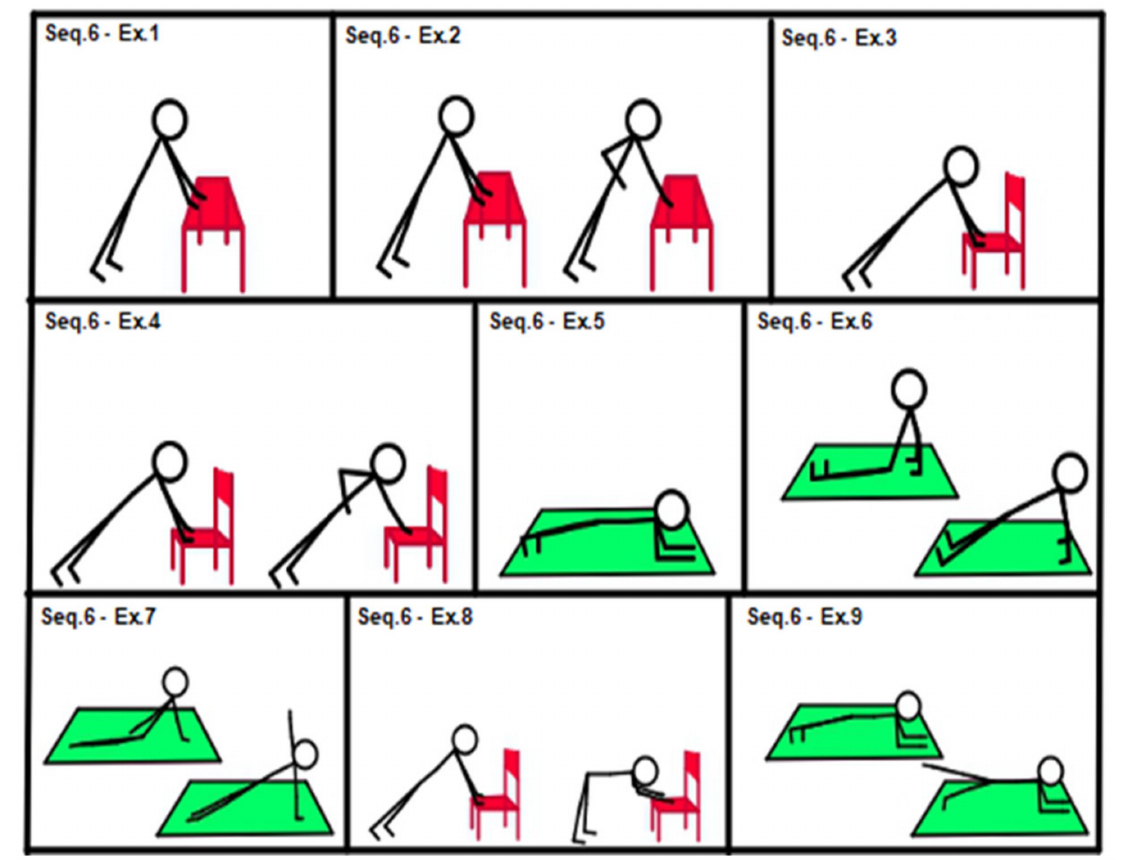
Figure 6. Sequence 6: core stability, medium level. Figure 4, Sequence 4: (1) side squat from a chair, hands on table; (2) chair side squat; (3) isometric single leg wall squat; (4) side squat, hands on table; (5) side squat; (6) walking side squat; (7) candelabrum side squat; (8) side squat with single front arm elastic band rowing; (9) side squat alternating arm elastic band rowing. Figure 5, Sequence 5: (1) isometric wall push-up (hands against the wall); (2) dynamic wall push-up; (3) isometric chair push-up (hands on chair seat); (4) chair push-up (dynamic movement, hands on chair seat); (5) easy push-up (knee on the floor); (6) easy double-time push-up (knee on the floor, isometric contraction between concentric and eccentric arm movement); (7) isometric push-up; (8) push-up; (9) push-up with single hip extension. Figure 6, Sequence 6: (1) table plank, (isometric, hands on table); (2) easy plank plus alternating arm row; (3) chair plank (isometric, hands on chair seat); (4) chair plank alternat- ing single arm row; (5) plank; (6) reverse plank; (7) side plank; (8) dynamic movement from chair plank to chair “v position” (hip flexed at 90 ◦ ); (9) plank with single hip extension. After completing the lower-level sequences, high-level sequences (sequences 7 and 8; see Figures 7 and 8) could be administered, if